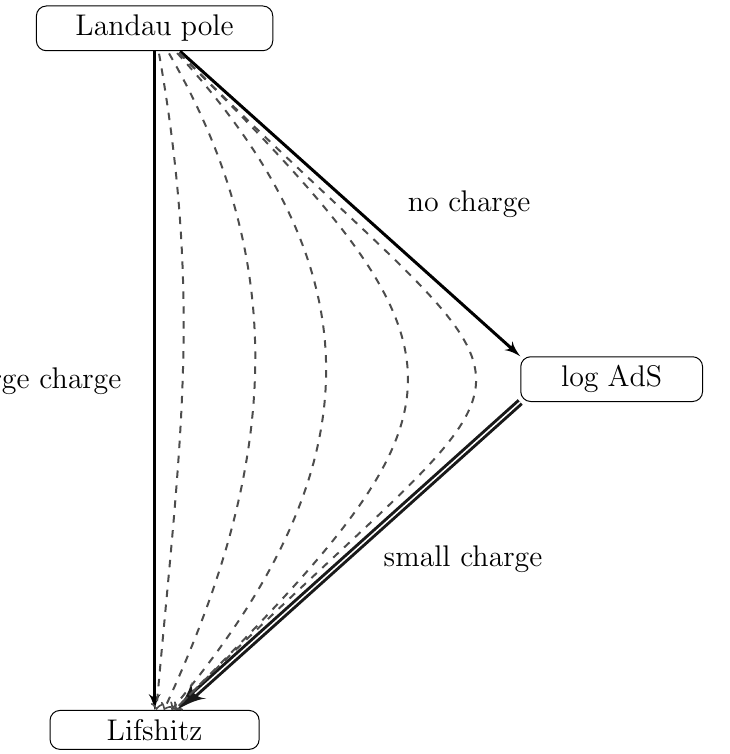
Figure 1. Pictorial representation of the family of supergravity solutions and corresponding RG (cid:13)ows constructed in this